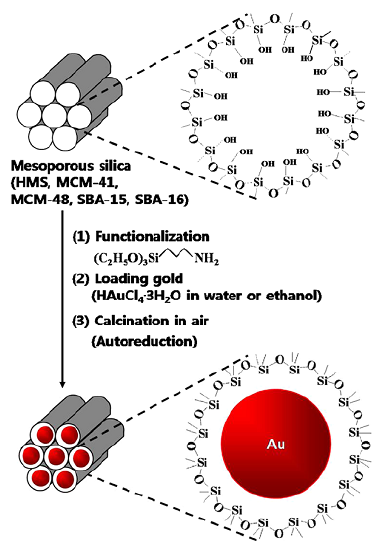
Figure 9. The general synthetic procedures of Au-NPs confined in channels of various mesoporous silicas. Reproduced with permission from [37]. Copyright 2009 Elsevier